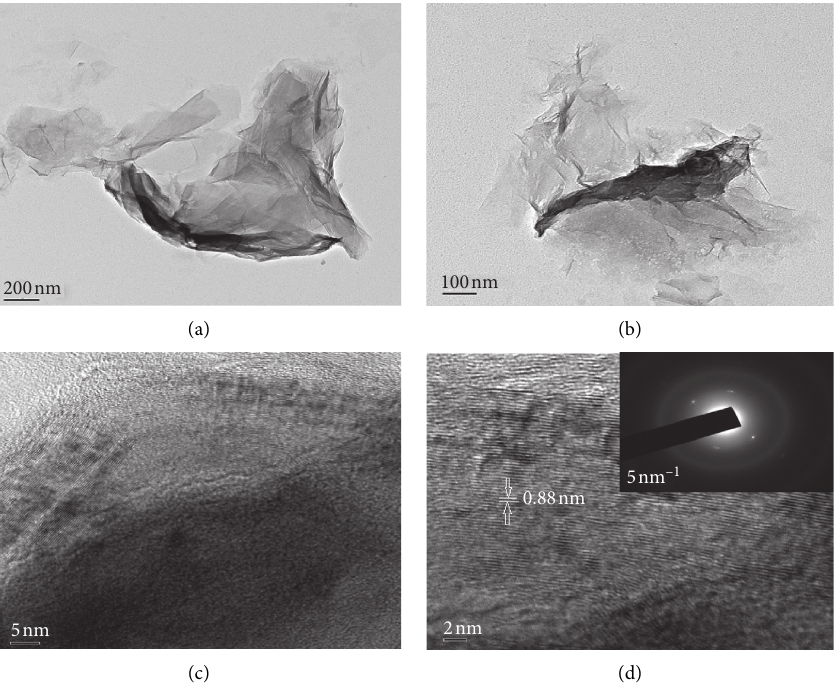
Figure 7: (a–d) TEM image of GO along with EDAX analysis, and the inset is SEAD pattern of GO.